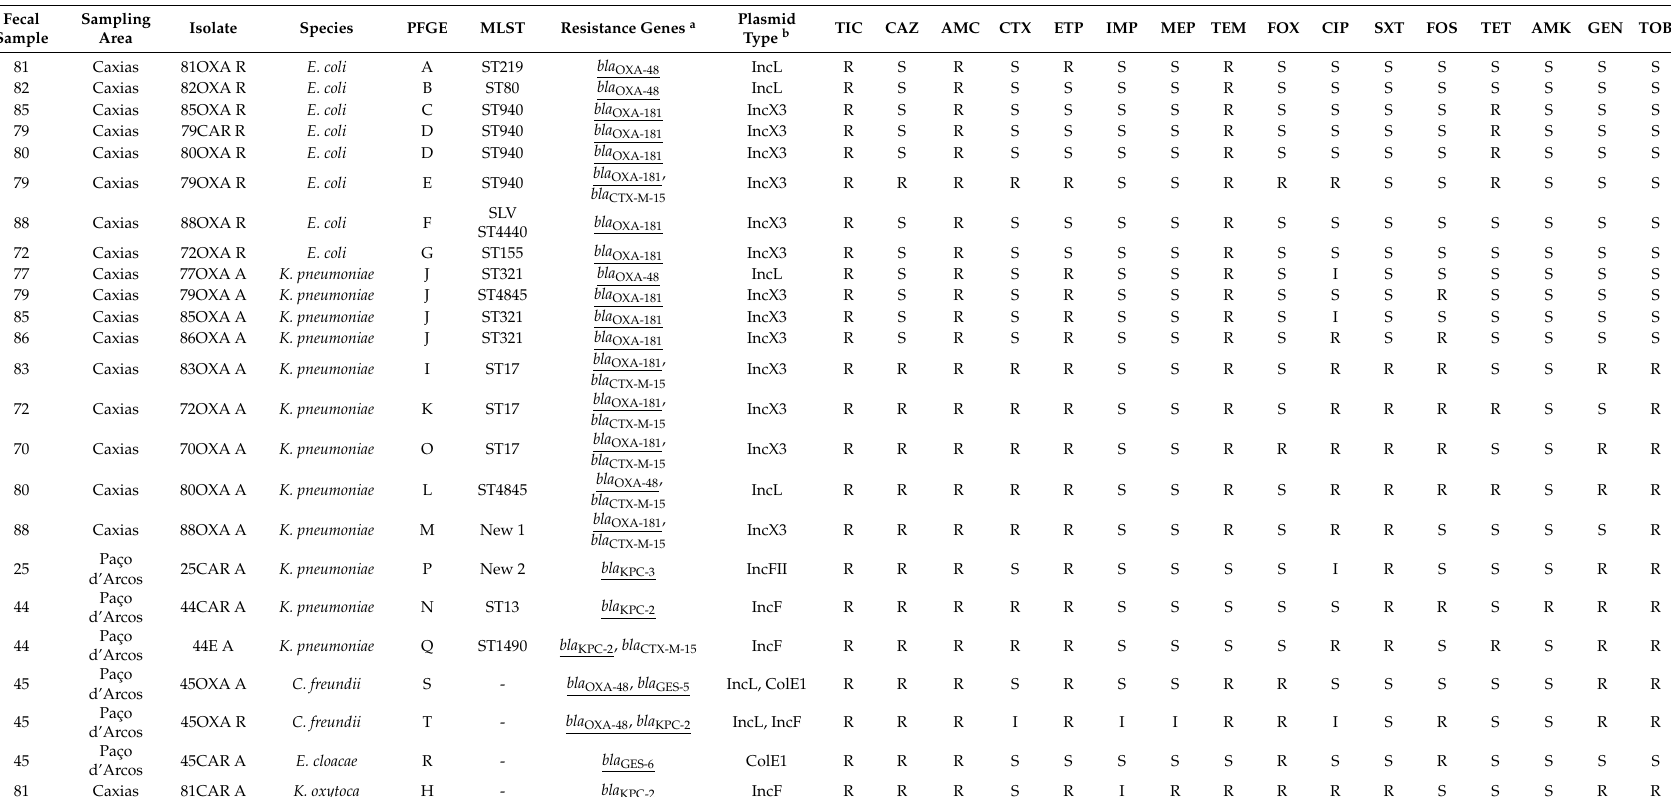
Table 2. Characteristics of the 24 carbapenemase-producing Enterobacteriaceae